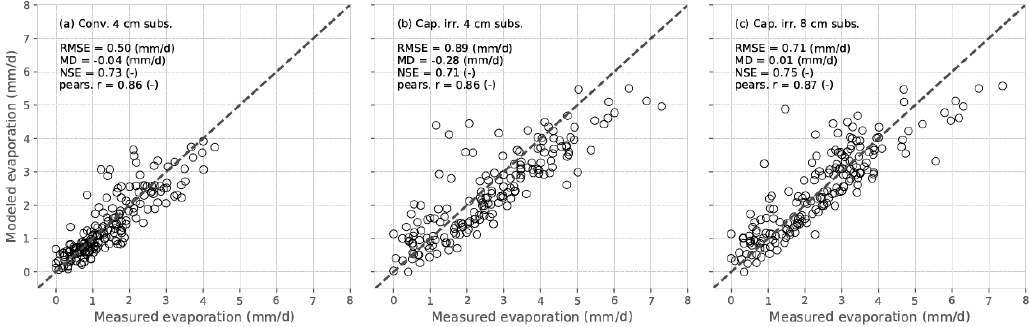
Figure 6. Measured against modeled daily actual evaporation. The dotted line represents the 1:1 line.